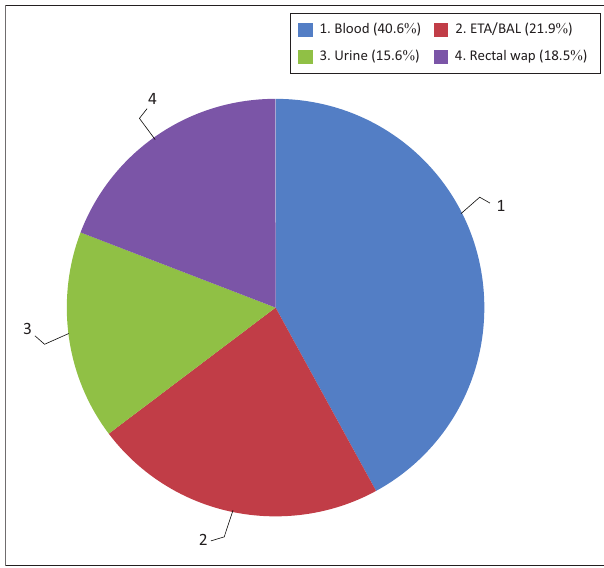
FIGURE 2: Distribution of culture results according to specimen type.